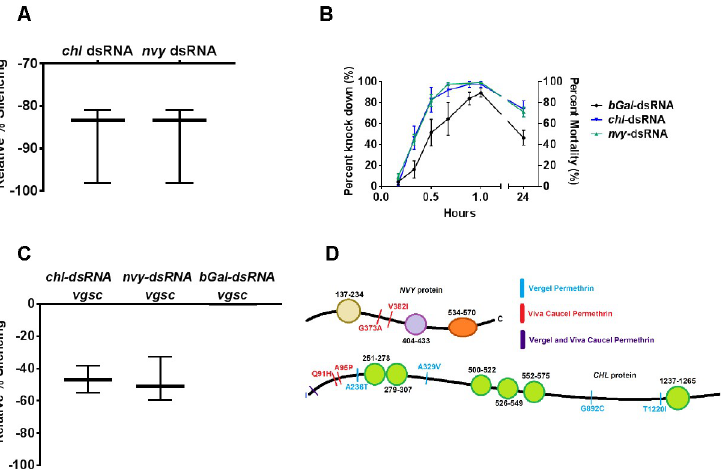
Fig 4. CHL- and NVY -silenced mosquitoes show increased susceptibility to permethrin and reduced VGSC transcript levels. A) Gene silencing validation. Mosquitoes were injected with either chl- dsRNA or nvy- dsRNA and processed in pools (n = 5) to isolate RNA at 3 days-post-treatment (dpt). Target transcripts were silenced an average of 93% and 78% in chl -dsRNA and nvy -dsRNA mosquitoes, respectively, relative to β Gal -dsRNA-injected controls. B) Mosquitoes were injected with β Gal -dsRNA (n = 113), chl -dsRNA (n = 172) or nvy -dsRNA (n = 129). At 3 dpt, each replicate was subjected to ~1.5 ug permethrin in a CDC bottle assay; knockdown was recorded at 10 minute intervals. There was a significant difference between chl and nvy compared to β -Gal controls ��� , (ANOVA, CHL , p < 0.0001; NVY , p < 0.0001). At 24 hours, mortality was also significantly elevated (Fisher’s Exact Test, CHL , p < 0.0001, NVY , p = 0.001). Left Y axis indicates percent knockdown from 10–60 minutes. Right Y-axis indicates percent mortality at 24 hours. Error bars indicate standard error of the mean (SEM). Bottle assay data represent a compilation of 4 to 5 biological replicates. C) Pools of 5 chl -dsRNA and nvy -dsRNA treated mosquitoes were subjected qRT-PCR of VGSC relative to β Gal -dsRNA injected controls. Results shown are the average of 3 biological and 3 technical